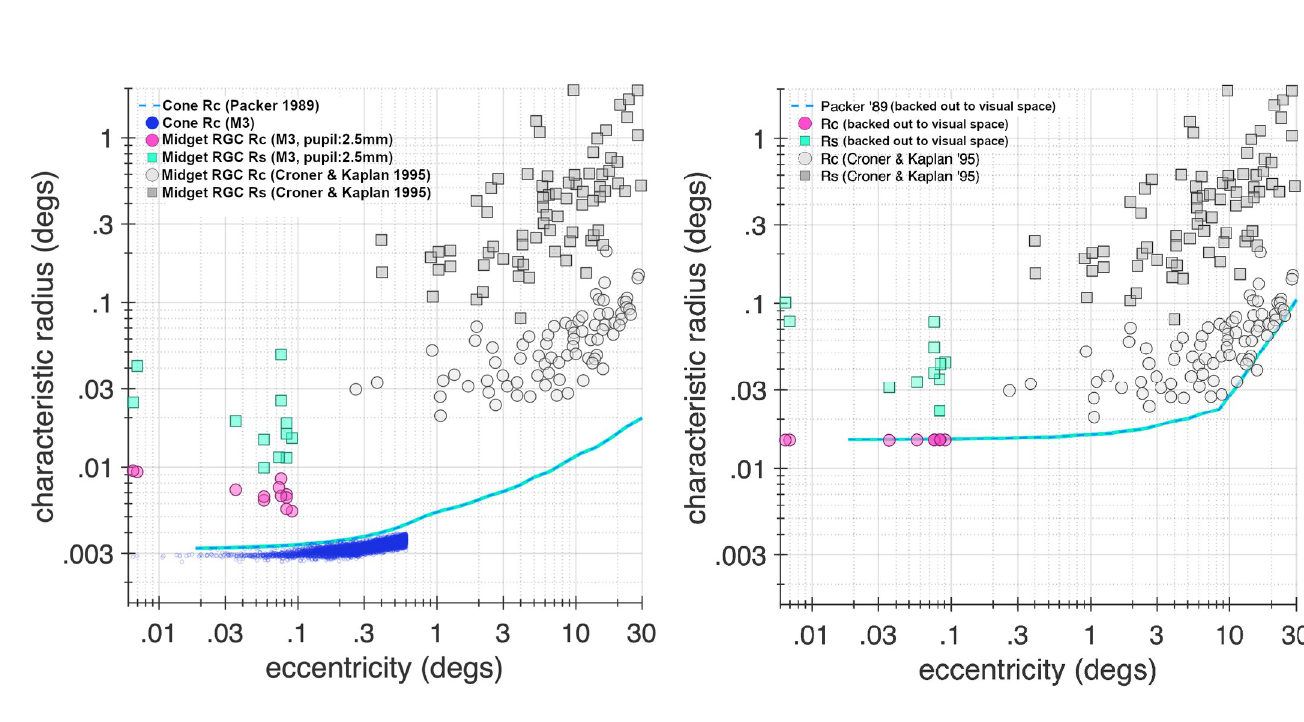
Fig 10. Comparison to extra-foveal in vivo midget RGC data. Data from M3 model fits are compared with extra-foveal data from Croner & Kaplan [9]. At left, gray circles and squares respectively show center and surround characteristic radii from Croner & Kaplan as a function of eccentricity, while pink circles and green squares show characteristic radii of centers and surrounds from M3 predicted using the ISETBio model with physiological optics accounted for. Light blue dashed line shows cone characteristic radii data from Packer et al . [99], while blue dots represent cone characteristic radii measured in foveal cones of M3. At right, the cone apertures of Packer et al . were transformed to their visual space counterparts using eccentricity dependent optics derived by off-axis wavefront measurements from human subjects from Jaeken & Artal [100] (blue line). The center and surround characteristic radii (pink circles and green squares) from M3 are also projected into visual space and lie along a natural projection of the Croner & Kaplan